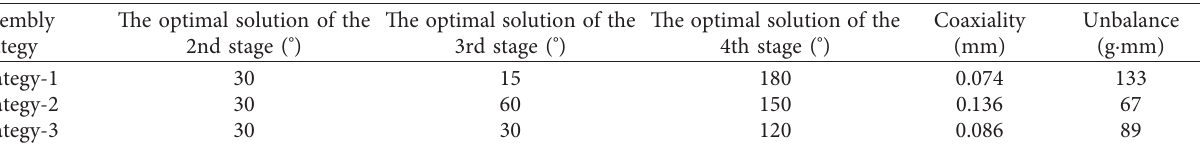
Table 9: The experimental results of the 4-stage rotor.